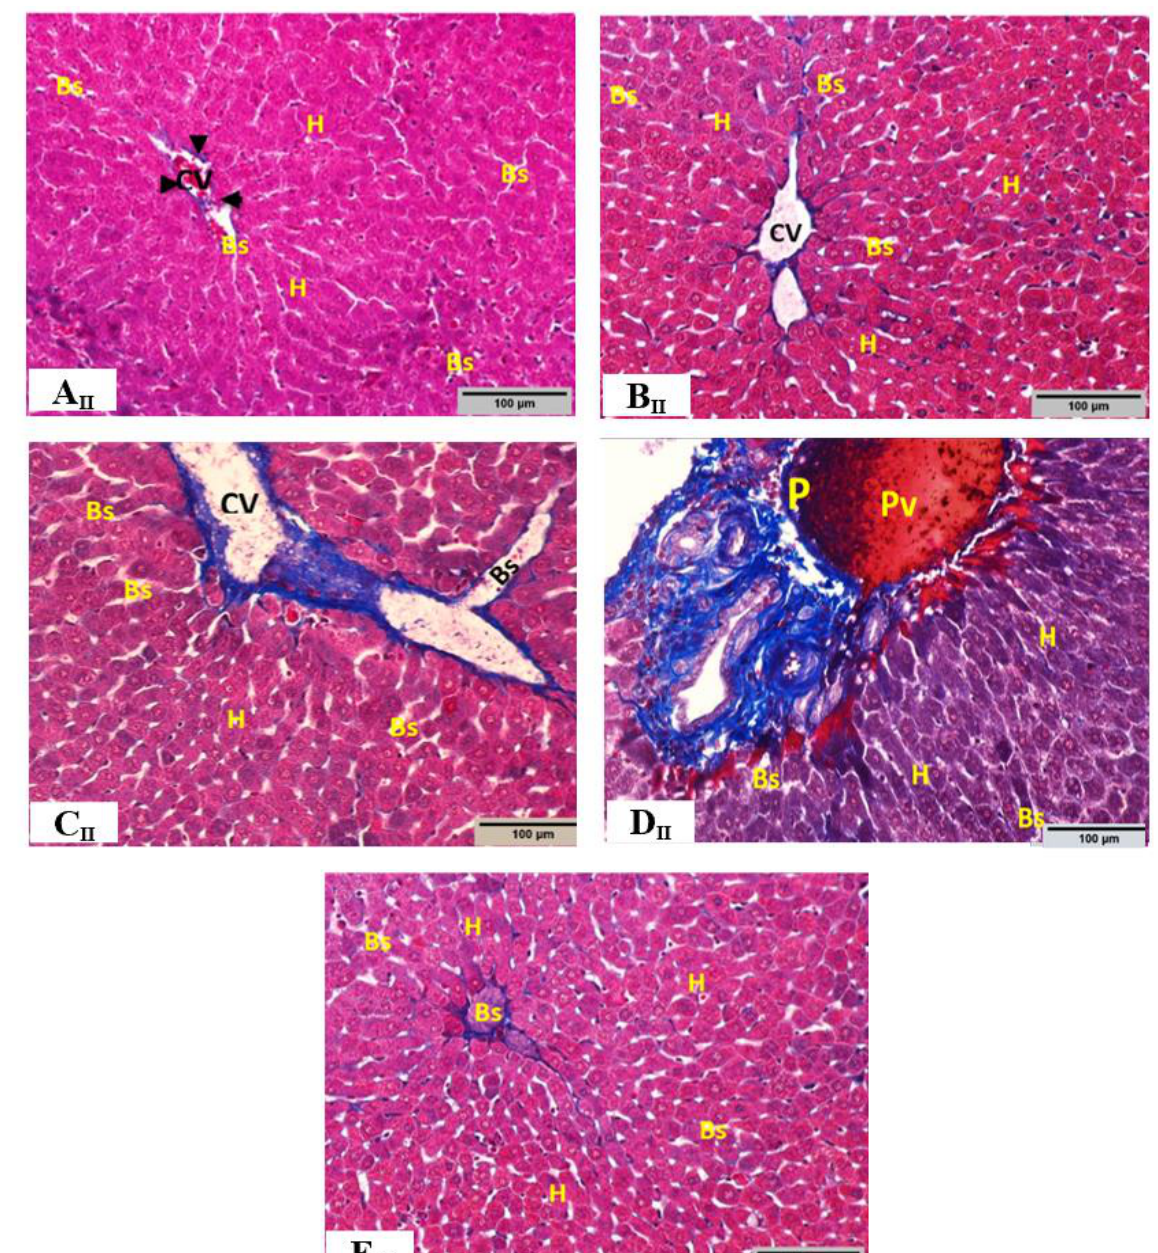
Figure 3. II. Representative images of Masson’s trichrome staining sections for liver tissues of control and experimental groups. ( A II , B II ): The hepatic tissues of control and C. myrrha extract-treated rats; respectively; showed a normal distribution of collagen fibers (blue) in sinusoidal spaces (Bs), around the central vein (Cv) which was bounded by an intact endothelium (arrowheads), and between parallel cords of hepatocytes (H). ( C II , D II ): The hepatic tissue of ethanol-treated rats showed a high deposition of collagen fibers (blue) around the central vein (Cv), dilation and congestion of portal vein (Pv) with portal spaces (P) expanded by abundant fibrous tissues (blue) as a marker for severe periportal fibrosis. ( E II ): Group treated with C. myrrha extract + ethanol showed noticeably reduced periportal fibrosis (blue). (200 × , scale bar 100 µm).